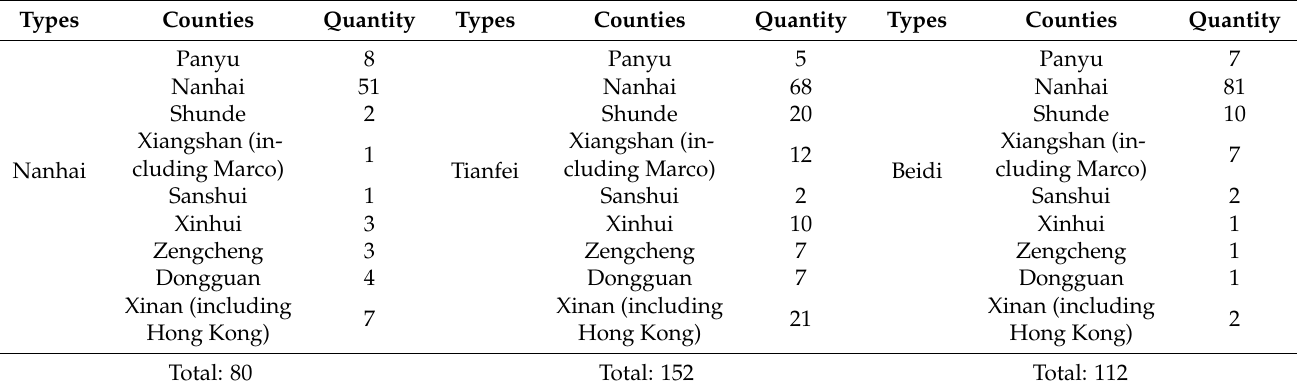
Table 1. Statistics about the Water Deities’ temples in the